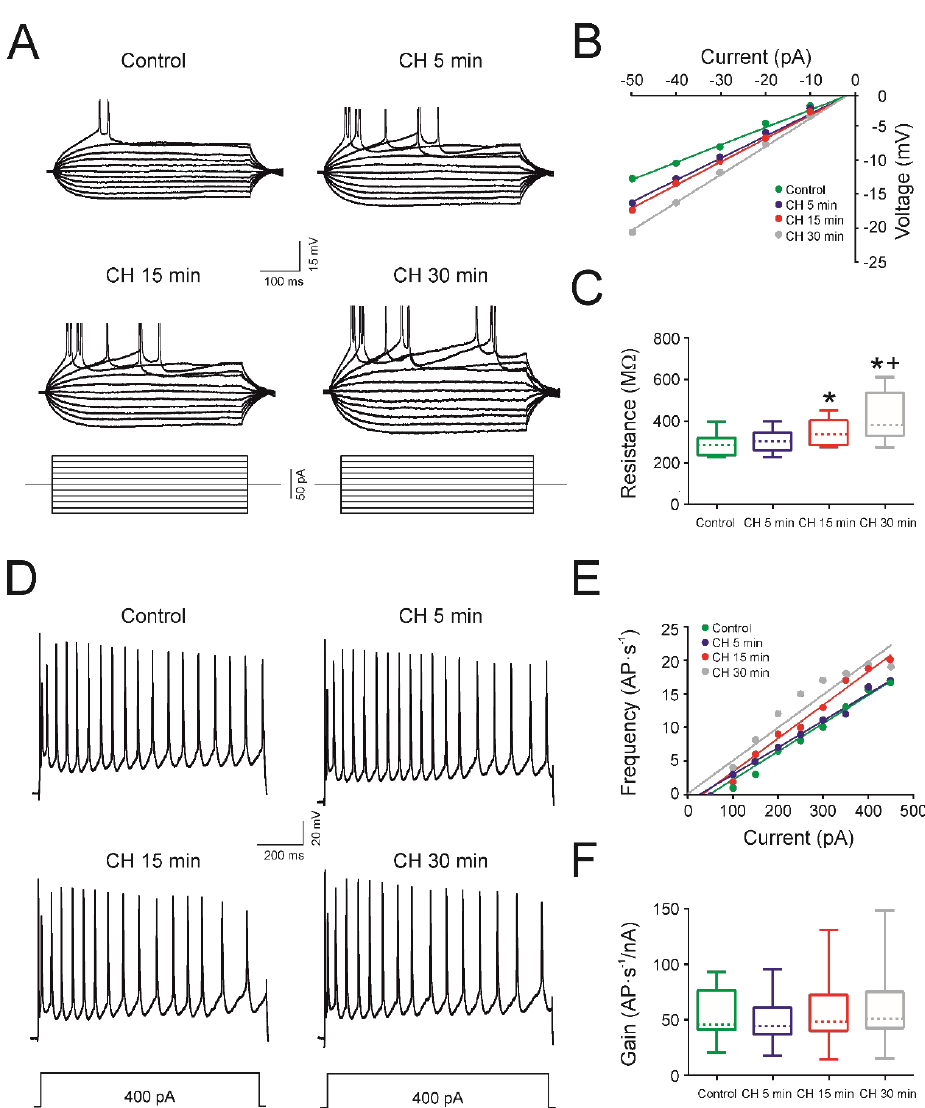
Figure 2. Effects of cumene hydroperoxide (CH) on the input resistance and firing properties in infantile rats. ( A ). Membrane voltage responses to depolarizing and hyperpolarizing current pulses in the same cell for control conditions and 5, 15, and 30 min after CH administration (10 μM). ( B ). Relationship between values of current and voltage represented in A. ( C ). Effect of the CH on the membrane input resistance represented as a box and whisker plot showing the medians (dashed lines), interquartile ranges (boxes), and minimum/maximum values (whiskers) for respective datasets ( n = 15). The box plot shows an increase in input resistance 15 min after CH administration. ( D ). Membrane potential responses to long-lasting depolarizing current pulses in the control situation and 5, 15, and 30 min after CH exposition. ( E ). Relationship between the current intensity and frequency of action potentials (AP) represented in D. ( F ). Effect of the CH on the gain represented as a box-and- whisker plot showing the medians (dashed lines), interquartile ranges (boxes), and minimum/maximum values (whiskers) for respective datasets ( n = 15). No changes in gain were detected after CH application. In C, an asterisk indicates a significant difference from the control condition, and a cross indicates a difference between adjacent columns. The significance level was established as p ≤ 0.05.